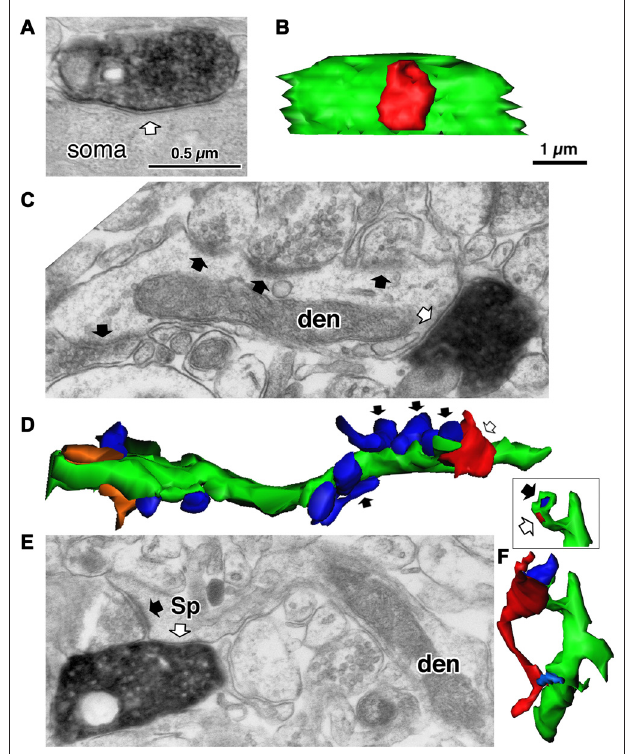
FIGURE 4 | Three different target structures of the inhibitory synapses. (A) A symmetrical synapse (white arrow) of the LS neurogliaform (LS-NG) cell onto a postsynaptic soma. (B) 3D reconstructed image of the synaptic structure shown in (A) . The axonal terminal of the LS NG cell (red) innervates the soma (green). (C) A symmetrical synapse (white arrow) from a corticotropin releasing factor (CRF) positive double bouquet cell onto a dendritic shaft (den) with frequent asymmetrical inputs (black arrows). (D) 3D reconstructed image (green) of the dendrite shown in (C) . Arrows indicate the same axon terminal boutons shown in (C) . Red is an axon terminal of the double bouquet cell. Blue structures are boutons forming asymmetrical synapses. Orange structures are boutons forming symmetrical synapses. (E) A symmetrical synapse (white arrow) from a CR positive double bouquet cell onto a spine head (Sp), which is also innervated by an asymmetrical synapse (black arrow). Scale in (A,C,E) shares the scale bar shown in (A) . (F) 3D reconstructed image of synaptic structure shown in (E) . An axon terminal of the double bouquet cell (red) innervates the spine head (green), which is also innervated by an asymmetrical synaptic terminal (blue). Inset shows the two synaptic junctions (red and dark blue) on the spine, without the presynaptic boutons. Scale in (B,D,F) share the scale bar shown in (B) . Adapted from Kubota et al. (2007).